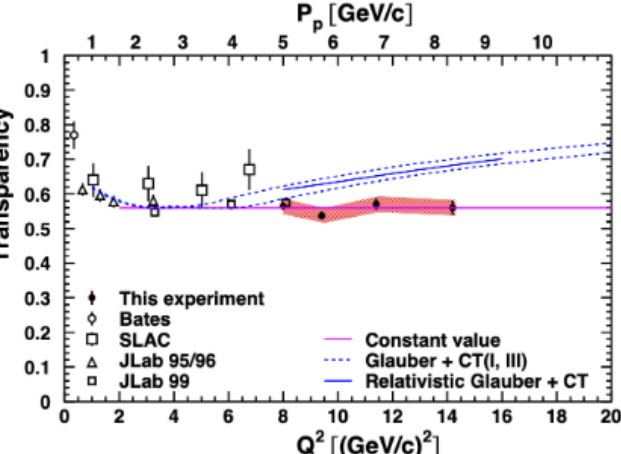
Figure 1. The JLab Hall-C 12 C( e , e (cid:48) p ) transparency results along with all previous experiments [20–24]. The momentum transfer squared, as well as the momentum of the knocked out proton are shown, respectively, in the bottom and top scale of the x-axis. The solid magenta line is for a constant value of 0.56. The dashed lines are theory predictions, including CT [27] for two different set of parameters and the solid blue line is a prediction from a relativistic Glauber calculation with CT [28]. The error bars show the statistical uncertainty while the band shows the 4% systematic uncertainty [26]. See text for